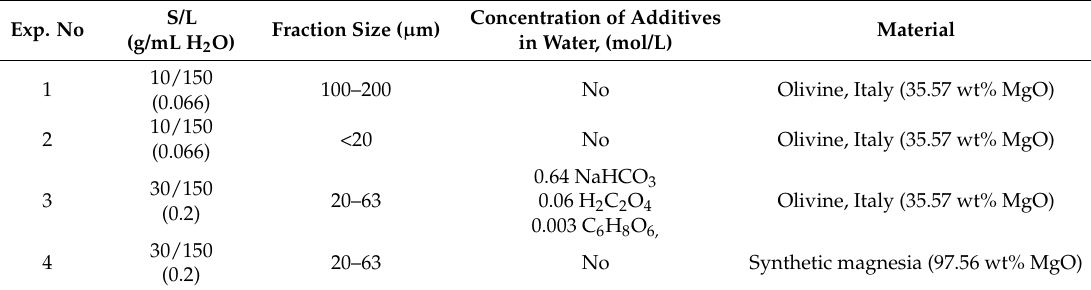
Table 2. Experimental plan (T = 175 ◦ C, pCO 2 : 117 bar, 300 rpm, 4